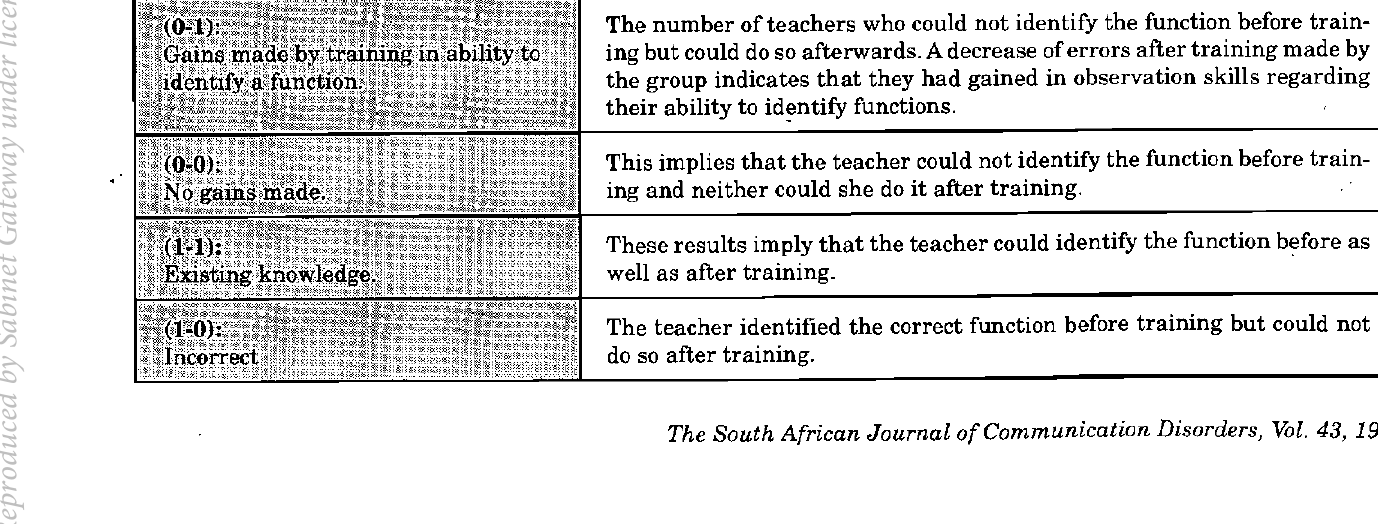
TABLE 3: Four types of results for identification of items (0-1): Gains made by training in ability to identify a